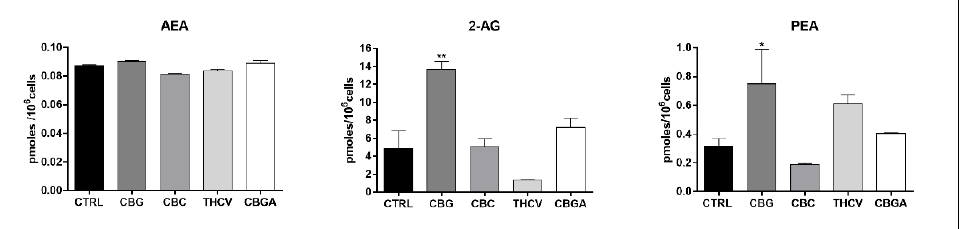
Figure 8. Endogenous levels of eCBs following 24 h of treatment with half-IC 50 amounts of CBG, CBC, THCV and CBGA. Data are the means ± SEM of two independent experiments ( n = 2). Statistical analysis was performed using a one-way ANOVA test, followed by the Bonferroni post hoc test (* p < 0.05 and ** p < 0.01 vs. control).